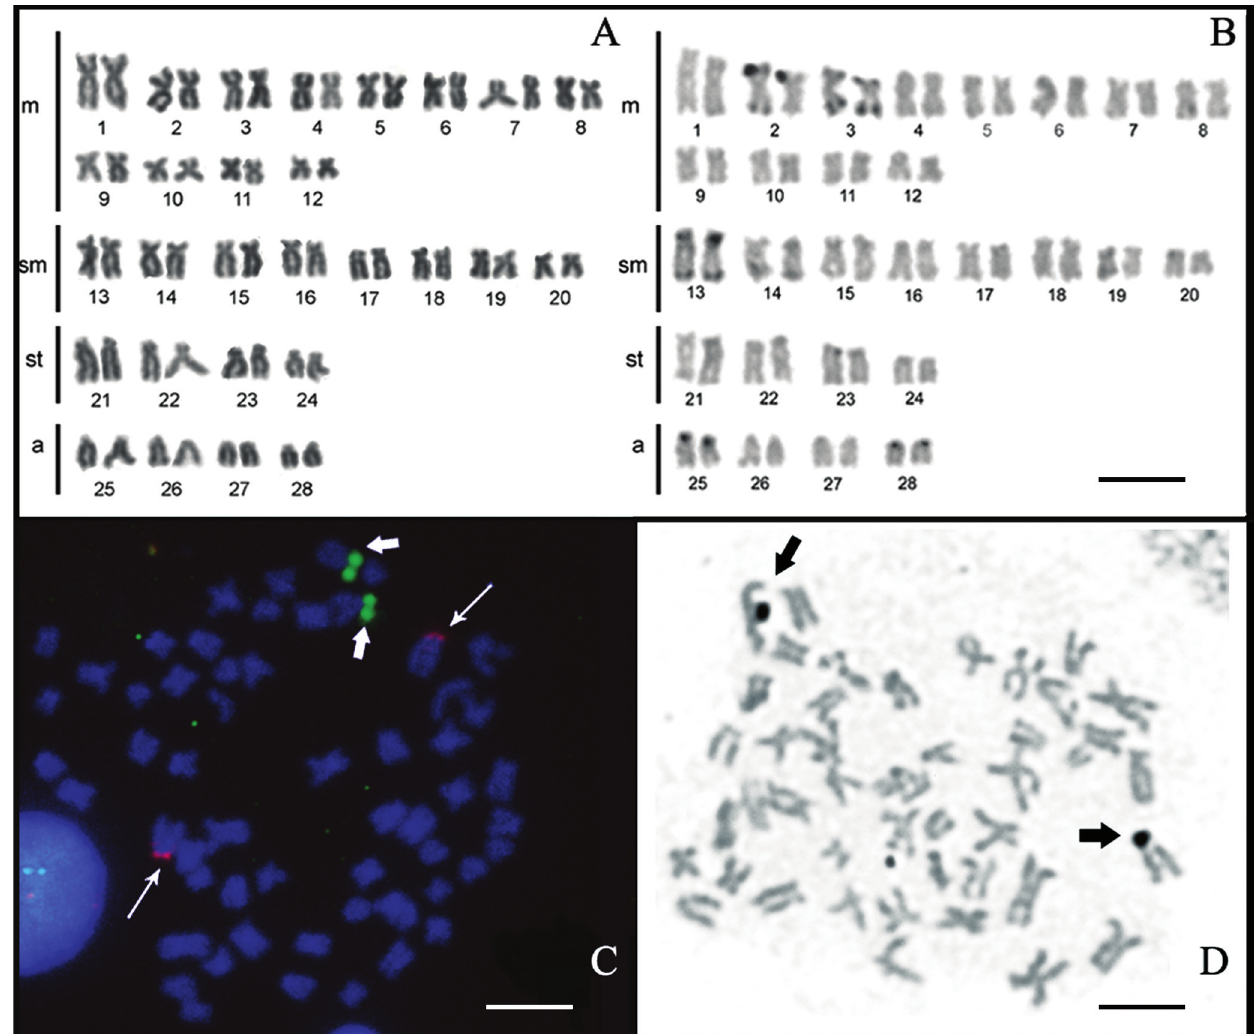
Fig. 3. Karyotype in Giemsa ( A ), C band ( B ), FISH with 18S probe (green arrows) and 5S probe (pink arrows) ( C ) and Ag-NORs ( D ) in Sorubim lima from the rio Paraguay (MS). m = metacentric; sm = submetacentric; st = subtelocentric; a = acrocentric. Scale bars = 10 μ